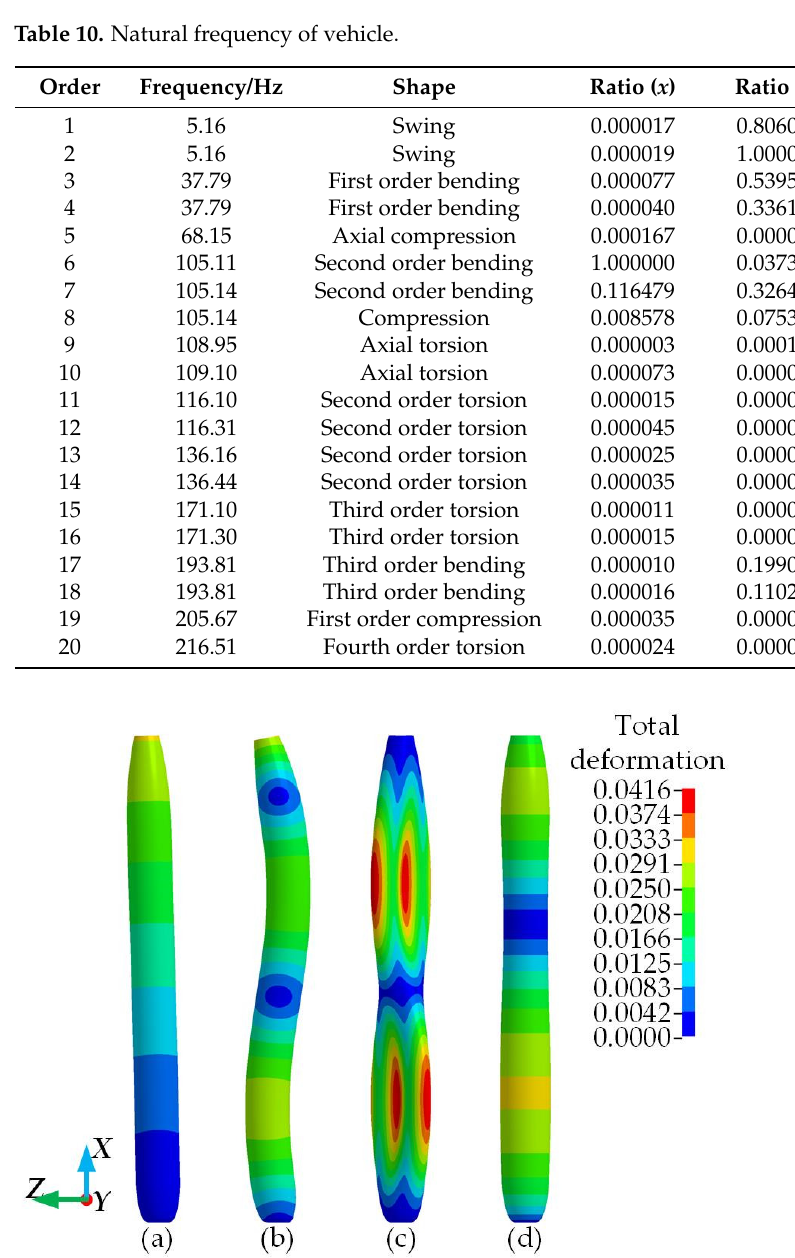
Figure 19. Shapes of 1st, 8th, 12th and 19th mode. ( a ) 1, ( b ) 8, ( c ) 12, ( d ) 19.